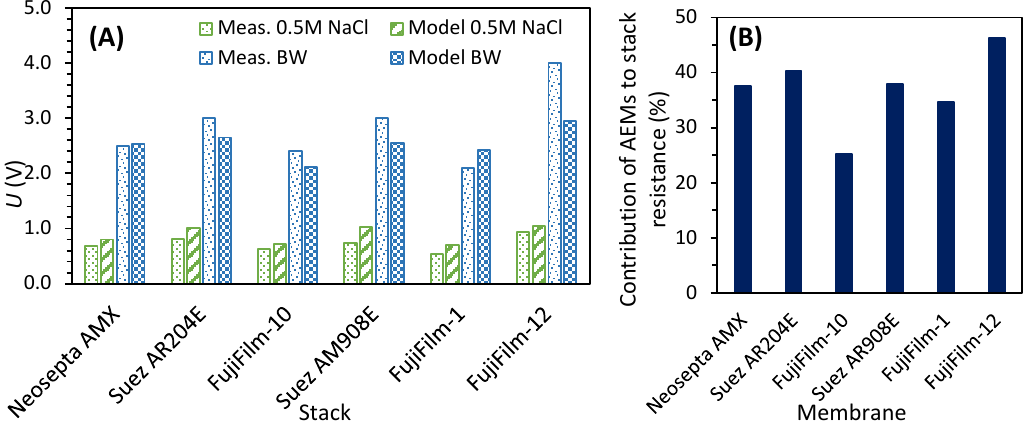
Figure 7. ( A ) Comparison of modeled and measured voltages for the different stacks operated at 100 A/m 2 . ( B ) Contribution of AEM resistance to the stack resistance according to the model for the BW solution.